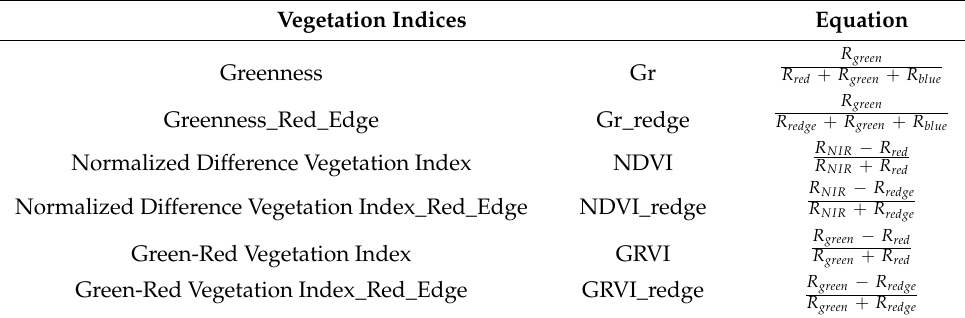
Table 2. Vegetation indices used in this study. R NIR , R redge , R red , R green and R blue are the reflectance in the respective